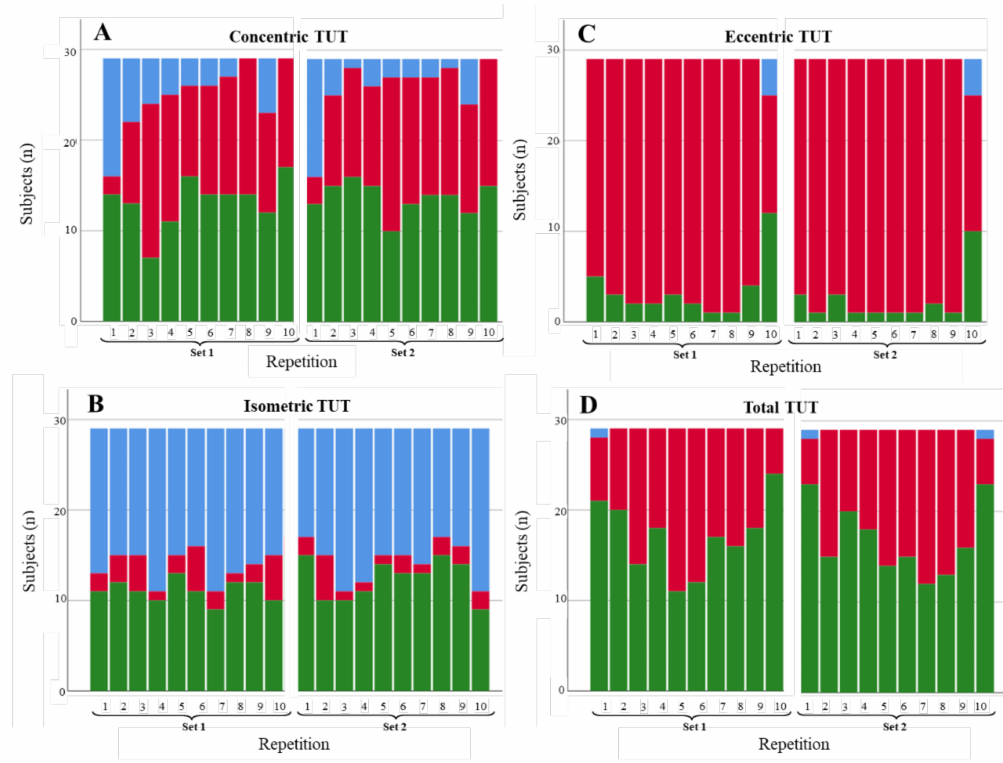
Figure 5. Degree of compliance of the TUTs for the restricted abduction ROM scenario by contraction phase: ( A ) concentric, ( B ) isometric, ( C ) eccentric, and ( D ) total. TUTs: in range = green; performed in less time than expected = blue; performed in more time than expected =